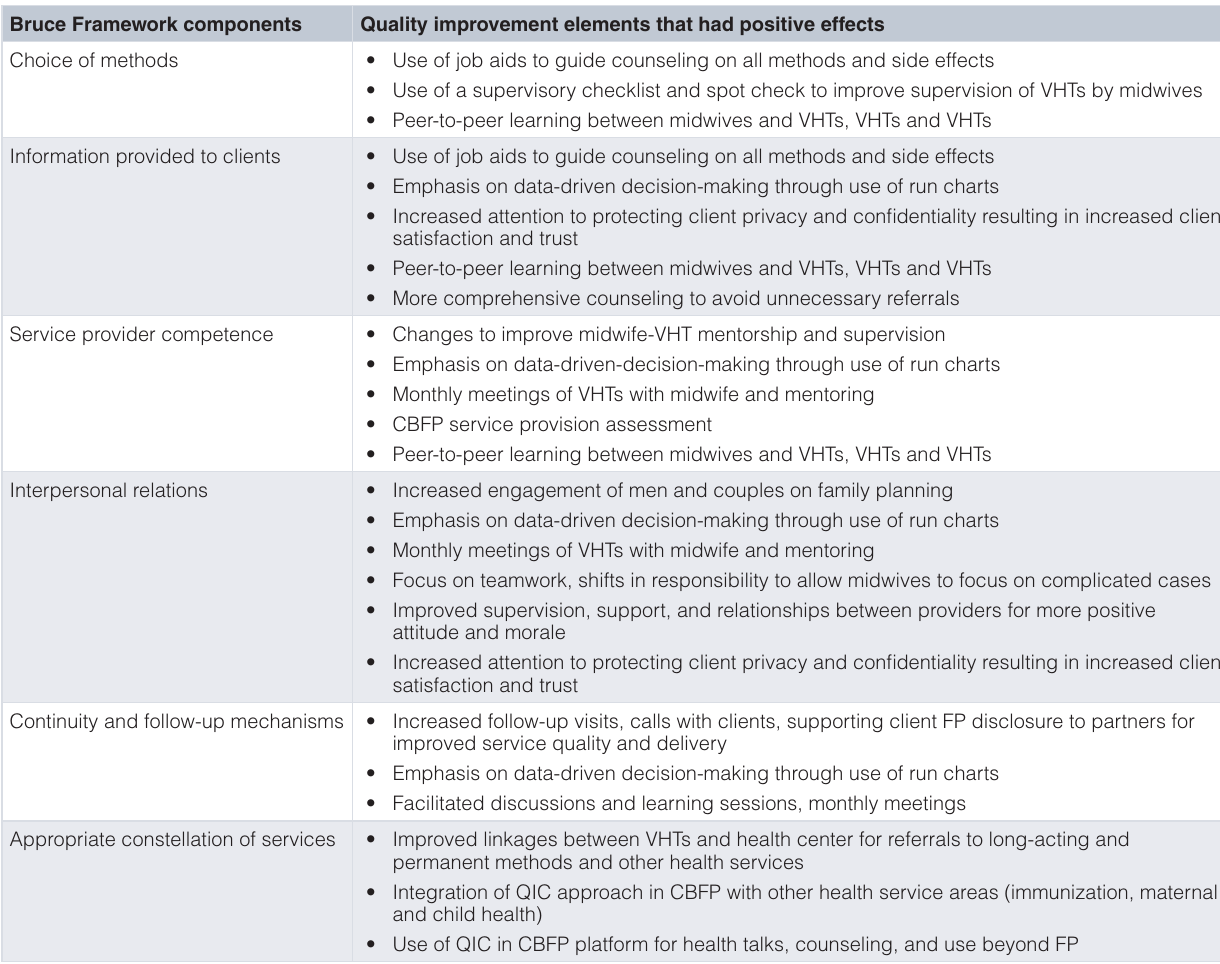
Table 5. How collaborative improvement supports Bruce Framework